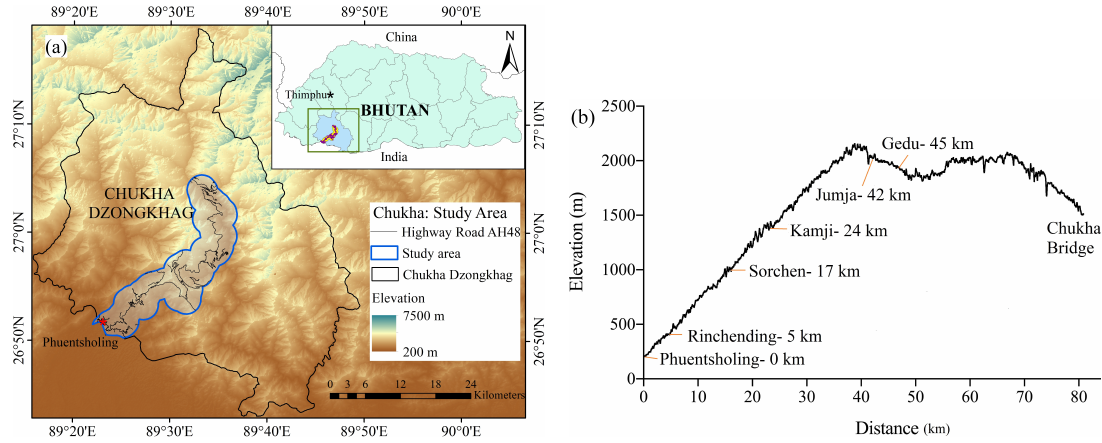
Figure 1. ( a ) Location map of the study area with a 2.5 km buffer along the 80.9 km Asian Highway/ Phuentsholing-Thimphu Highway (AH48) superimposed on an elevation map ( b ) Elevation profile up